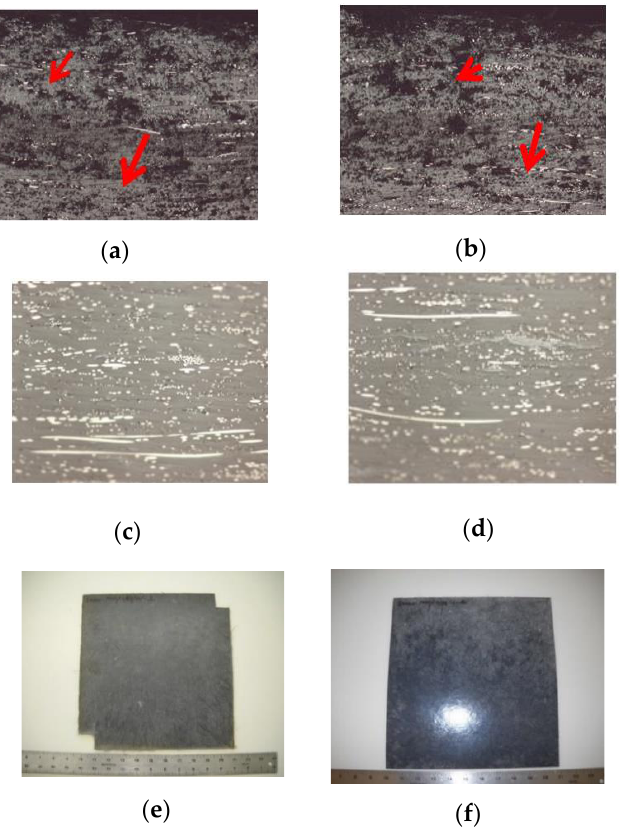
Figure 1. Effect of consolidation; ( a ) PA66/CF/68/30, 5 layers of preform (less-consolidated panel); ( b ) PA66/CF/88/10, 5 layers of preform (less-consolidated panel). Arrows point to representative voids in both ( a , b ); ( c ) PA66/CF/68/30, 5 layers of preform (well-consolidated panel); ( d ) PA66/CF/88/10, 5 layers of preform (well-consolidated panel); ( e ) PA66/CF/68/30 less-consolidated panel, the PA66/CF/88/10 was similar in look; ( f ) PA66/CF/68/30 well-consolidated panel, the PA66/CF/88/10 was similar in look; Panel size 275 mm × 275 mm.